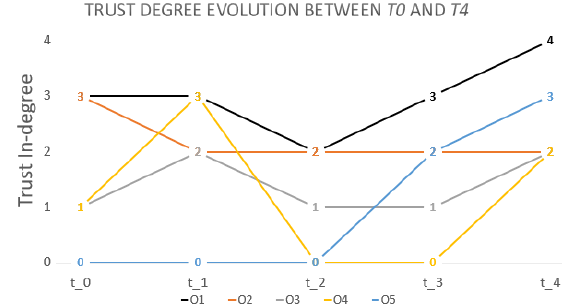
Figure 4. Trust degree evolution between t0 and t4 for project